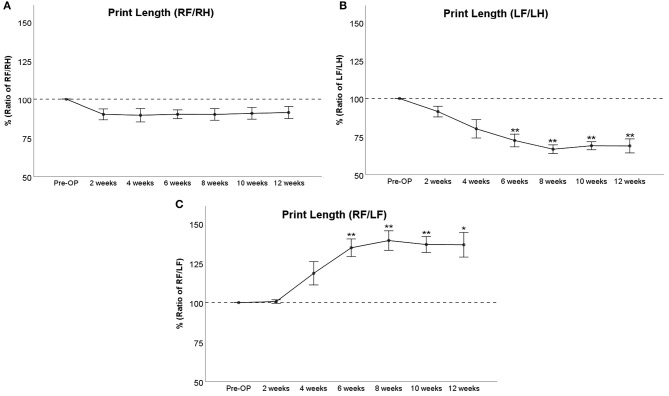
Course of Print Length following bilateral median nerve resection and unilateral autograft repair displayed as ratio of right front paw (RF)/right hind paw (RH) (A), left front paw (LF)/left hind paw (LH) (B), or RF/LF (C), *p < 0.05 as compared to Pre-OP, **p < 0.01 as compared to Pre-OP.